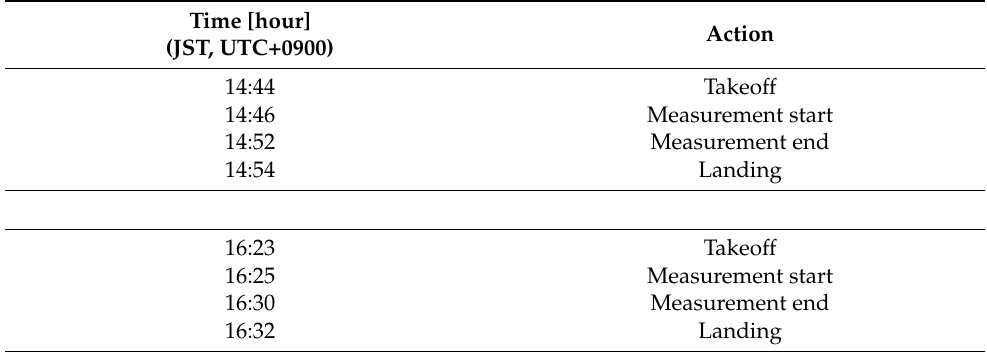
Table 1. Time schedule during the communication test in Section 3.1 (two